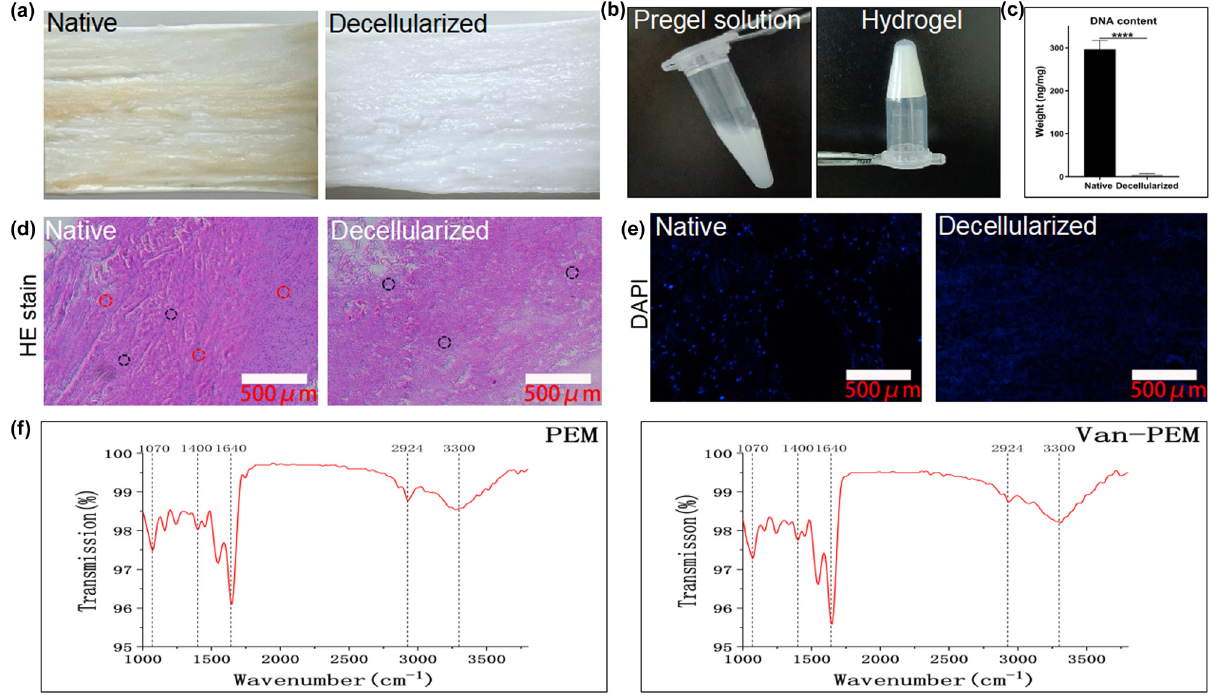
Figure 1: ( a ) Primary and post - acellular periosteum. ( b ) Pregel solution under acidic conditions and solid gel under neutral conditions. ( c ) Changes in the DNA content before and after the acellular process. DNA tests con fi rmed the removal of the nucleus. ( d ) H&E staining before and after periosteum decellularization con fi rms the complete removal of cells ( red dashed circles ) and the preservation of collagen fi bers ( black dashed circles ) . ( e ) DAPI staining before and after the acellular process. DAPI staining demonstrated that the periosteum was completely removed after acellular treatment. ( f ) FTIR spectra of the PEM and Van - PEM hydrogels, and it was con fi rmed that the addition of vancomycin did not react with PEM hydrogel to generate new chemical